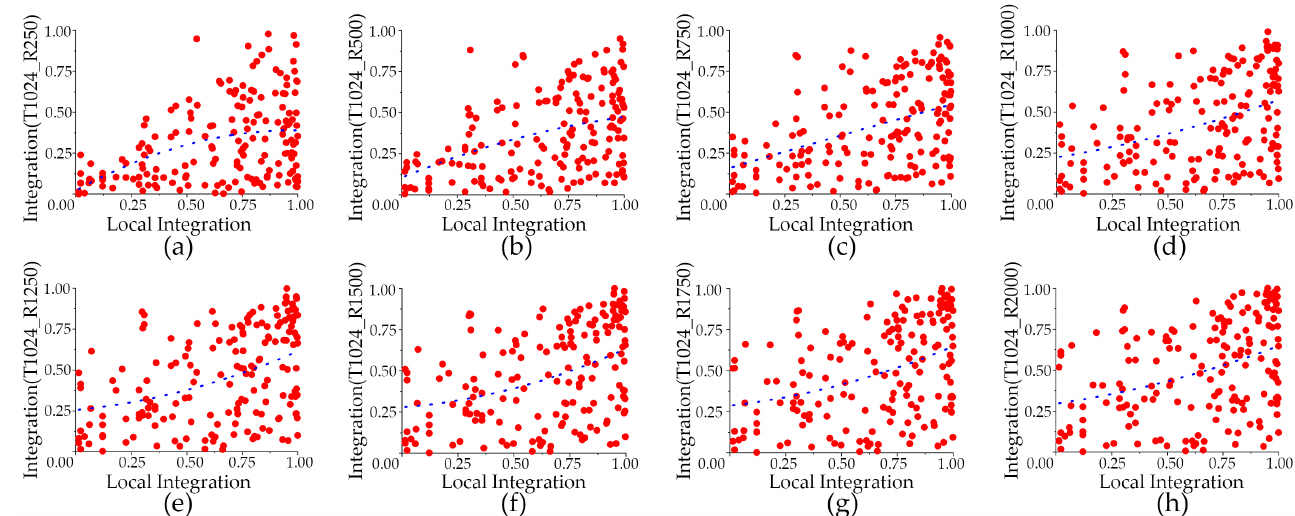
T1024_R1000; ( d ) Global Integration and T1024_R1250; ( e ) Global Integration and T1024_R1500; ( f ) Global Integration and T1024_R1750; ( g ) Global Integration and T1024_R2000.